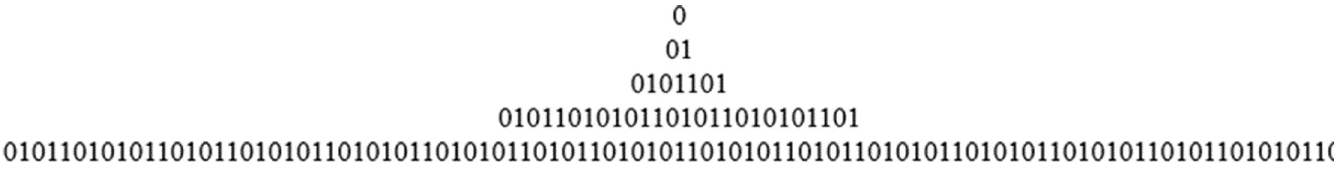
Fig 6. Graphical representation of a skip